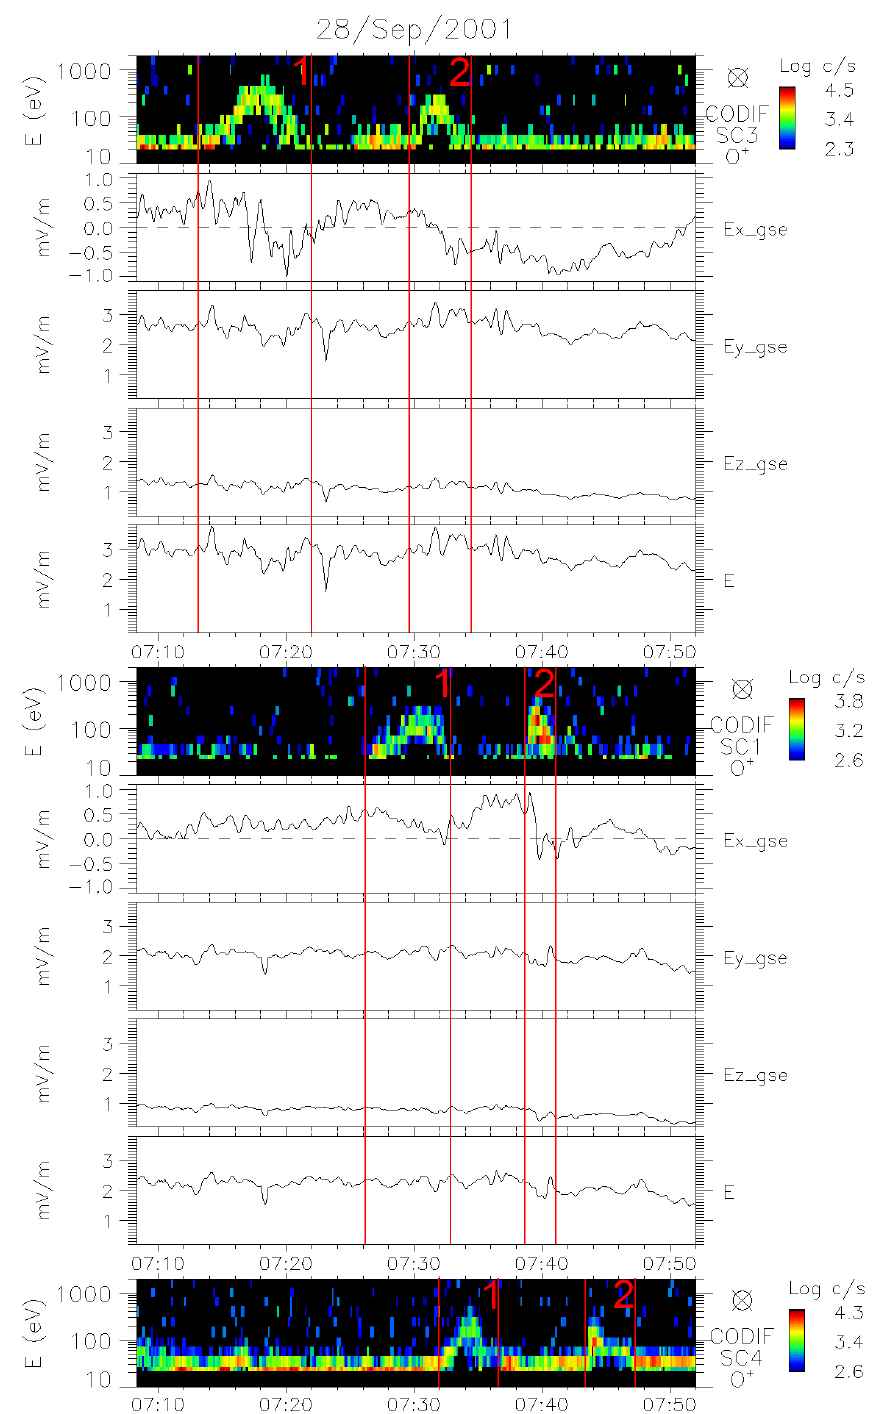
Fig. 7. 28 September 2001. From top to bottom: Energy-time spectrogram from CODIF for O + ions, spacecraft 3. GSE components of the convection electric field as given by EDI, spacecraft 3. Energy-time spectrogram from CODIF for O + ions, spacecraft 1. GSE components of the convection electric field as given by EDI, spacecraft 1. Energy-time spectrogram from CODIF for O + ions, spacecraft 4. The scale used to plot the x component of the electric field differs from the others, in order to better show its variation associated with the ion